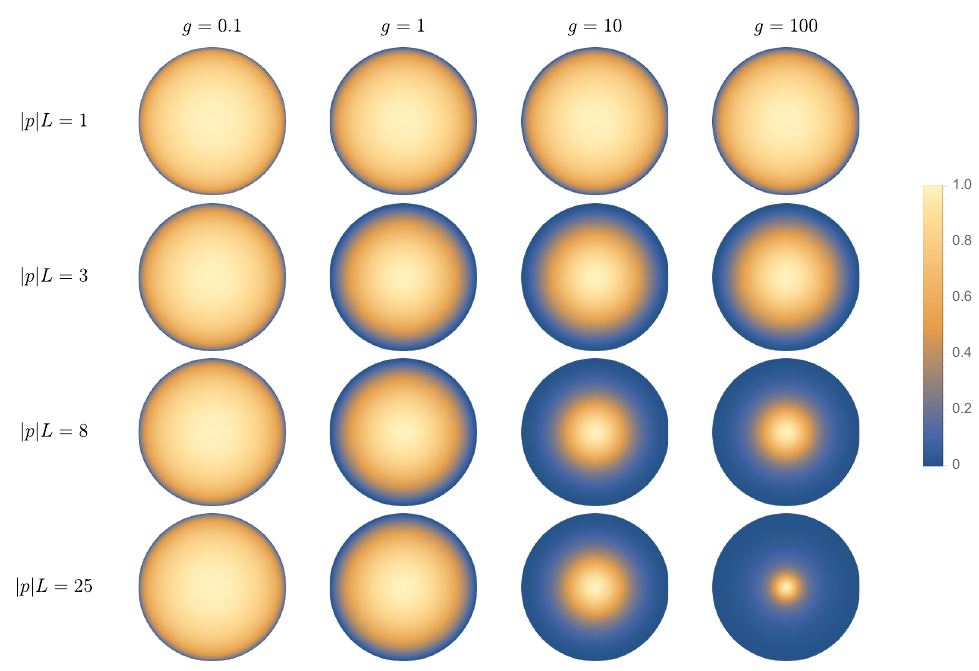
Figure 6 . Signal of the holographic camera (1.4) in planar N = 4 sYM theory, for various values of optical parameter | p | L and coupling constant g . Colors show the amplitude for receiving angles 1 2 y y ( p , p ) inside the unit disk, normalized by peak value. A narrow peak requires good optics and p 0 y p 0 y strong coupling. Above the diagonal, the camera’s angular resolution is limited by poor optics; below the diagonal, by dynamics; along the diagonal, these limitations are roughly